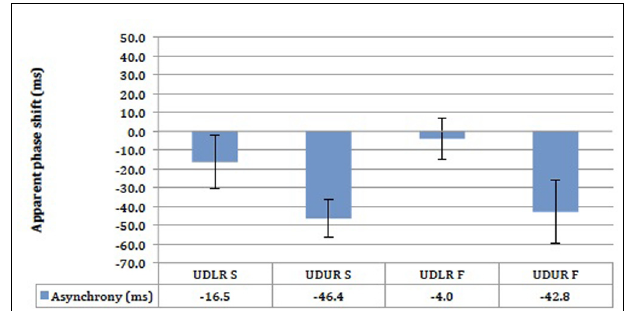
FIGURE 10 |The results of the stow motion-fast motion pairing experiment for four subjects. SS = stow motion paired with slow motion; SF = stow motion paired with fast motion (with stow motion as the reference stimulus); FF = fast motion paired with fast motion; FS = fast motion paired with slow motion (with fast motion as the reference stimulus). Error bars represent standard error of means